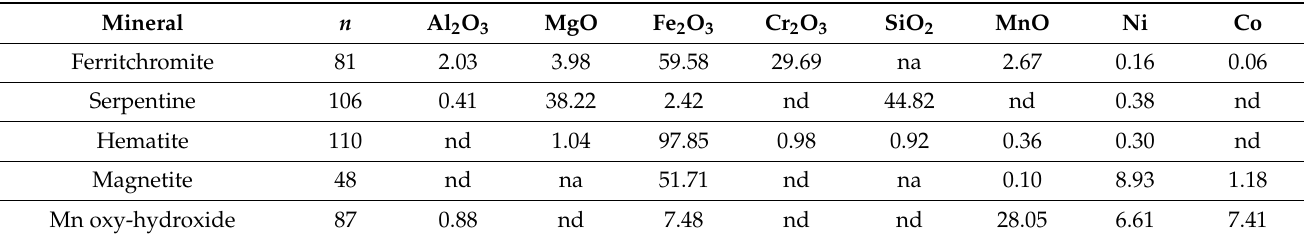
Table 5. Average wt% chemical compositions of the main minerals in the serpentinite. n = number of EPMA analyses; nd = not detected; na = not